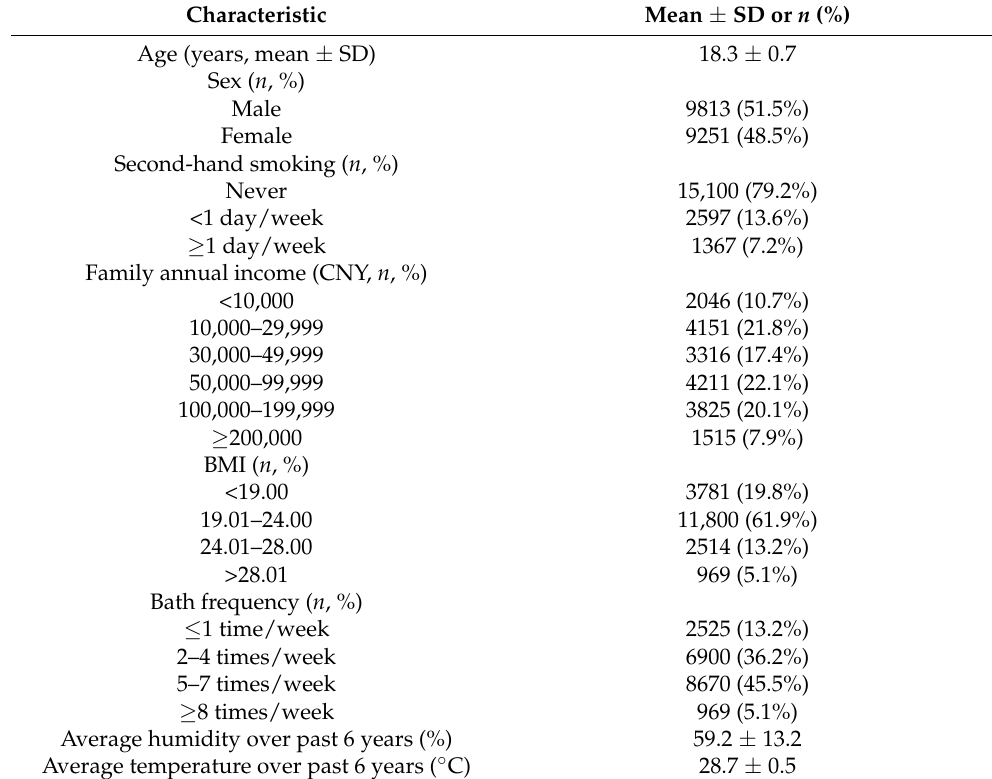
Table 1. Among these students, 481 (2.5%), 560 (2.9%), and 1332 (7.0%) were diagnosed with AD, CHE, and urticaria, respectively. The distribution of daily dose of exposure to O 3 , CO, NO 2 , SO 2 , PM 2.5 , and PM 10 level is summarized for the total population and separately for case and control for AD, CHE, and urticaria in Table 2. The levels of each pollutant were divided into four quartiles to assess OR for diseases. Table 1. General information of total study population ( n = 19,064).